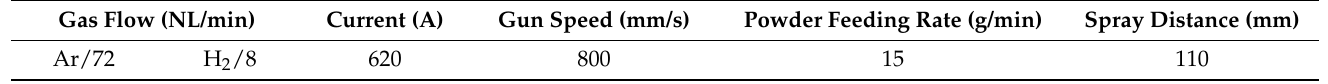
Table 2. Spray parameters to prepare Cu-doped Mn-Co spinel coatings.